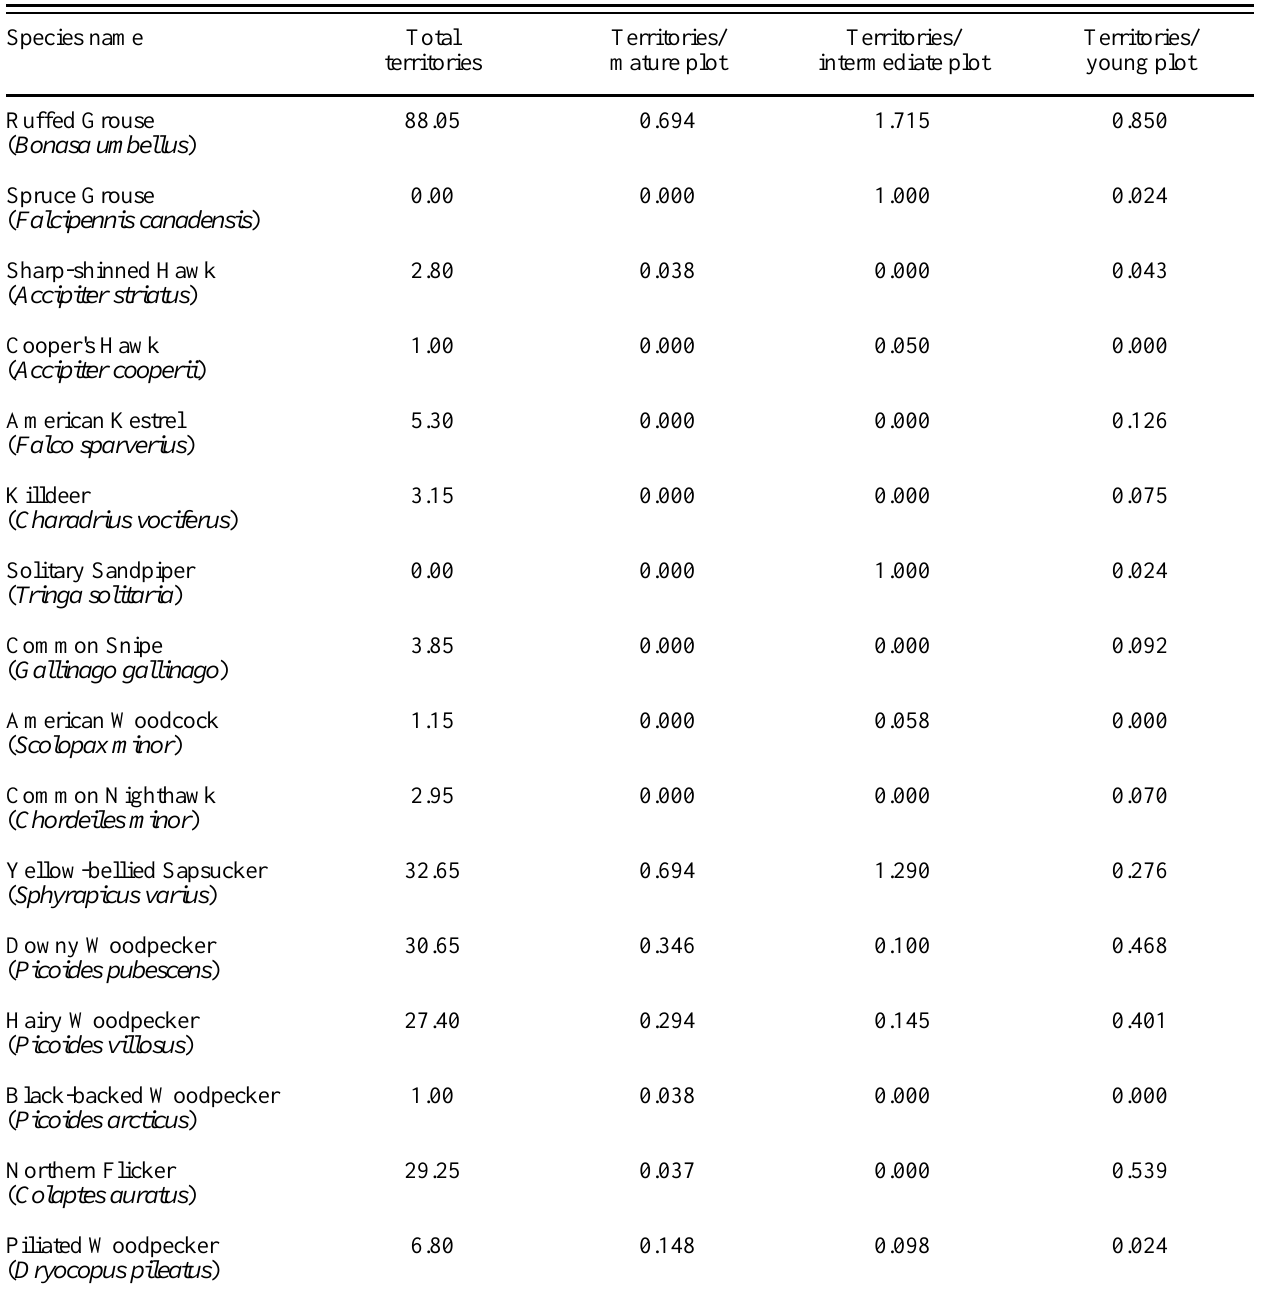
Table A2-1 . Species list, total territory count, and territory density for each age